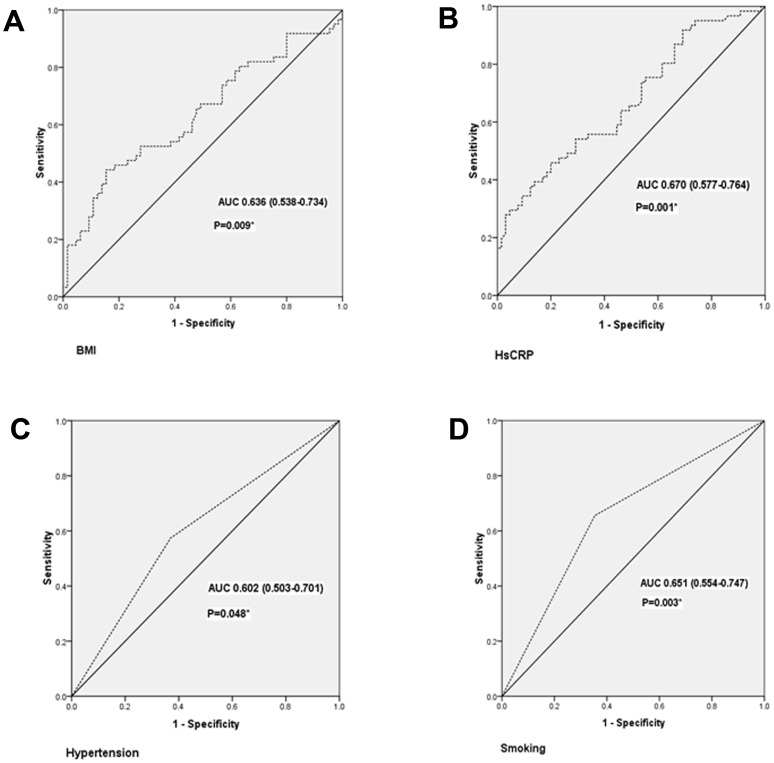
Receiver-operating characteristic (ROC) curve for factors in predicting high ABI (*P<0.05). BMI, body mass index; hsCRP, high-sensitivity C-reactive protein; AUC, area under the curve.